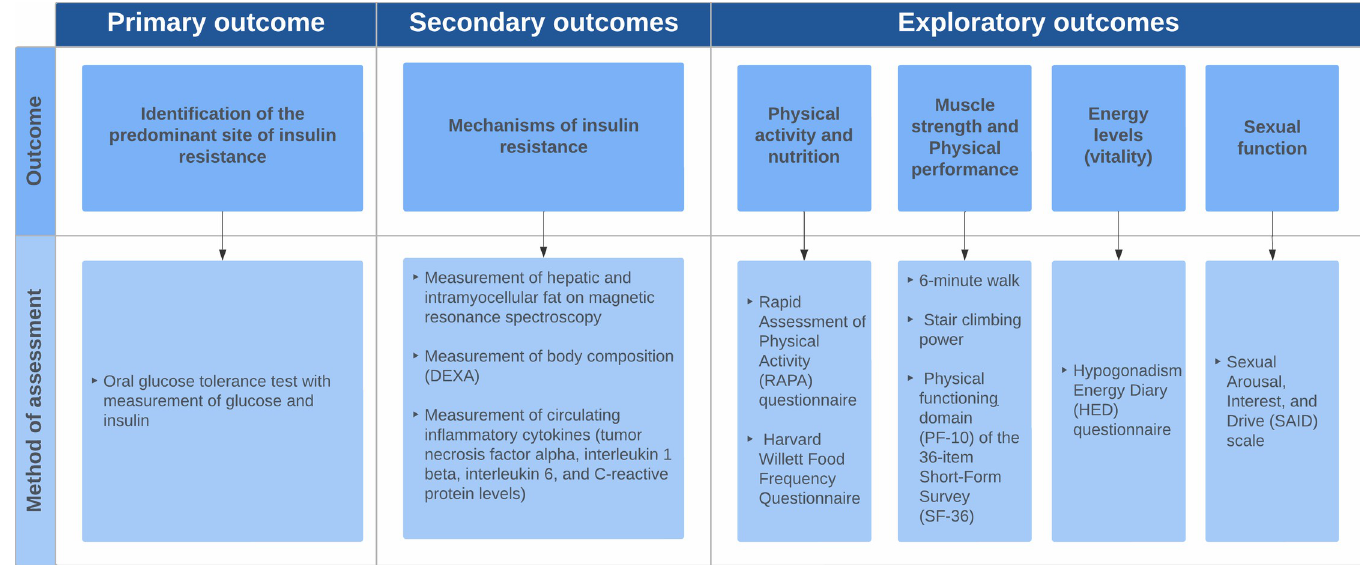
Fig 1. Primary, secondary, and exploratory outcomes of the study.